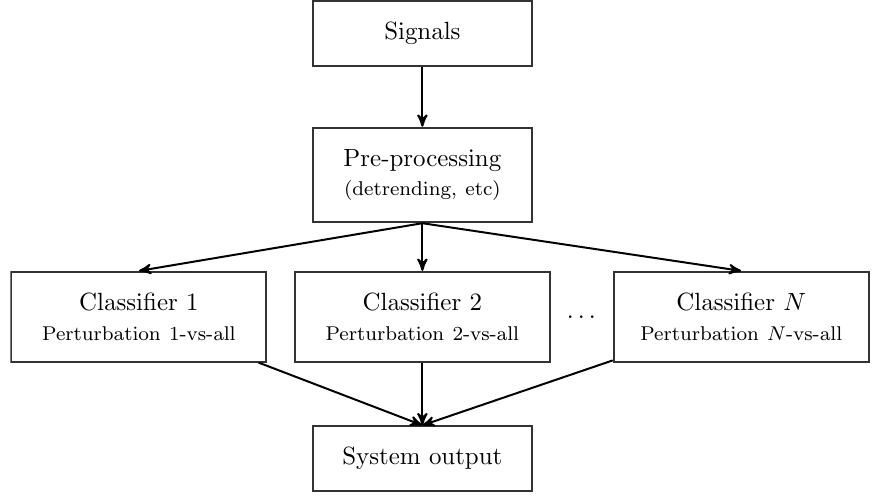
Figure 1: One-vs-All System